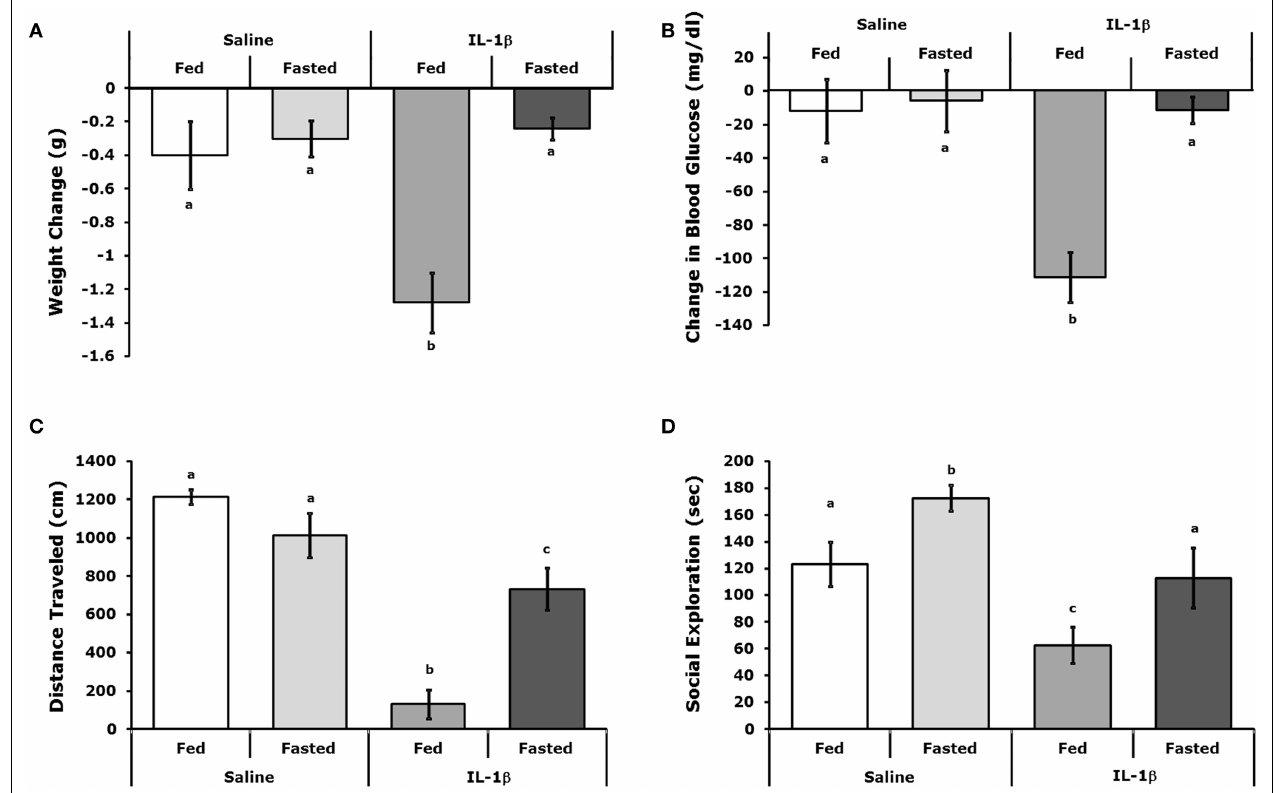
FIGURE 2 | Fasted mice are resistant to IL-1 β . Mice were fed or fasted for 24h. prior to IP IL-1 β or vehicle (Saline) administration. (A) Mice were weighed 2h after IL-1 β administration and compared to their weight just prior to IL-1 β administration. Results are expressed as weight change in grams (g), means ( ± SEM); n = 4–5. Bars without a common superscript are different (* P < 0.05). (B) Blood glucose was measured 2h after IL-1 β administration and compared to blood glucose just prior to IL-1 β administration. Results are expressed as change in blood glucose